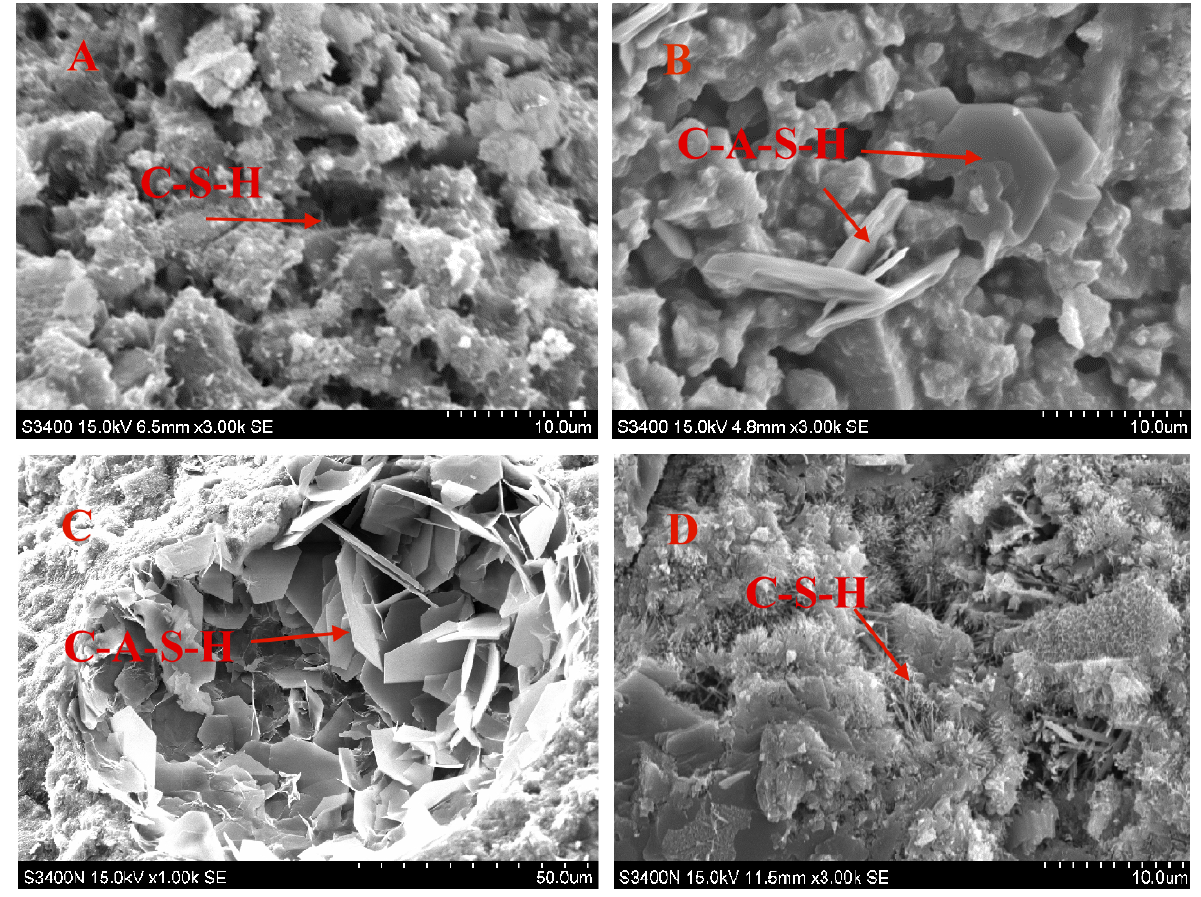
Figure 7. SEM micrographs of mixture CF co-firing fly ash and GGBS (28 days)